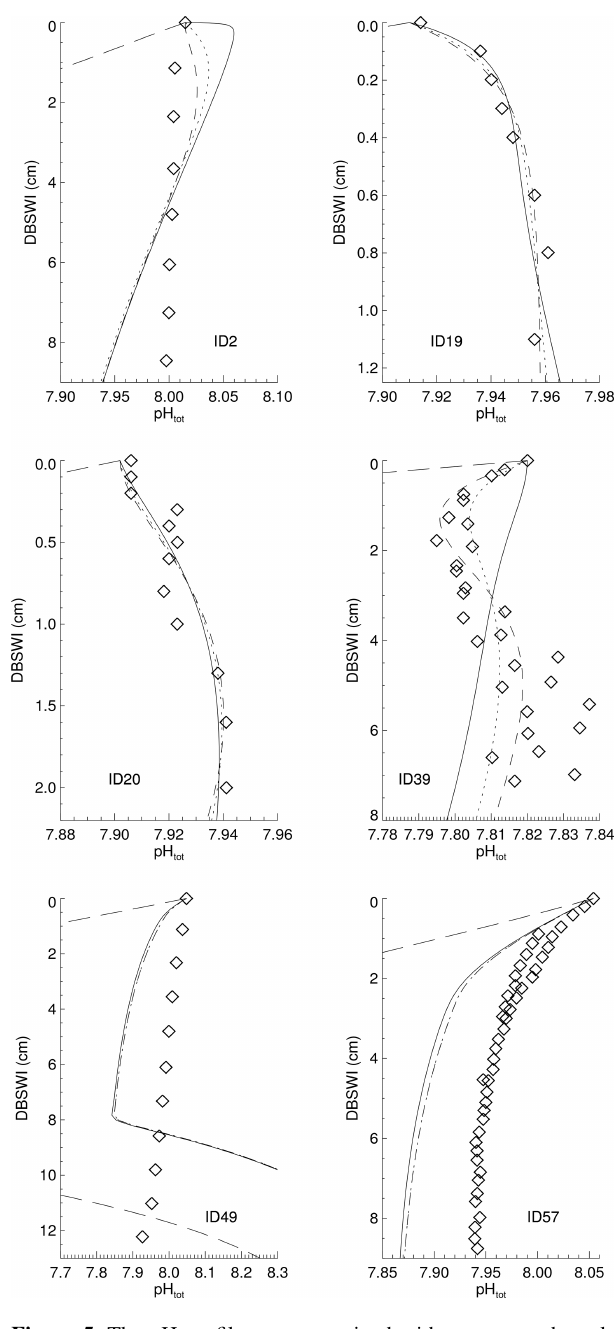
Figure 5. The pH profiles, unconstrained with respect to the cal- cite mass fraction in the deposition flux and in the surface solids, for stations that produced physically impossible fits (calcite mass fractions exceeding 100% either in the mass deposition flux or the solid concentration profile). Lines are as follows: long dashed – no calcite dissolution; full – calcite dissolution kinetics of order 4.5; dotted – order 2; short dashes –